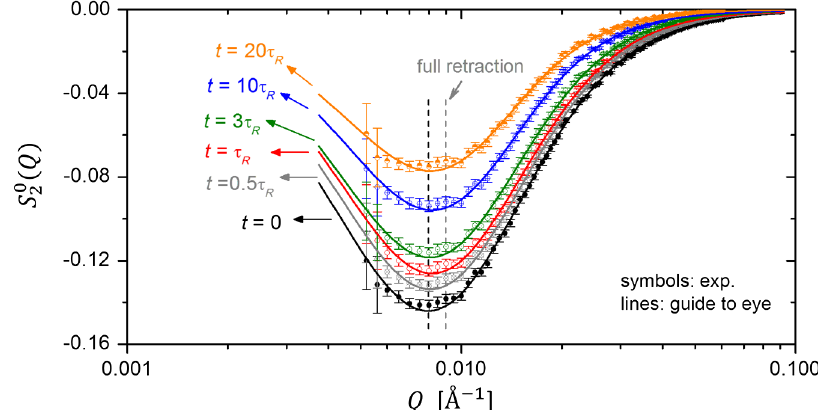
FIG. 5. Evolution of the expansion coefficient S 0 2 ð Q Þ . The vertical gray dashed line indicates the theoretically expected peak position after full chain retraction. The SANS data are collected on the NGB30 SANS beam line at